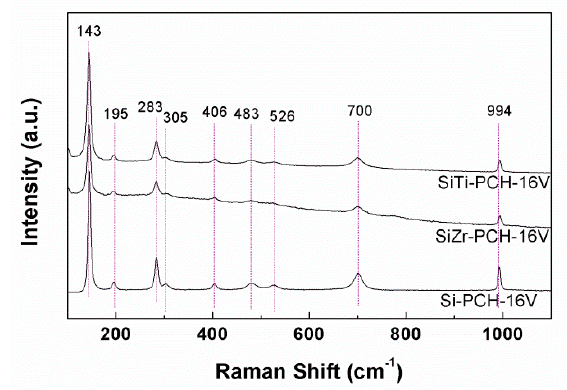
Figure 2. Raman spectra of Si-PCH-16V, SiZr-PCH-16V and SiTi-PCH16V catalysts.